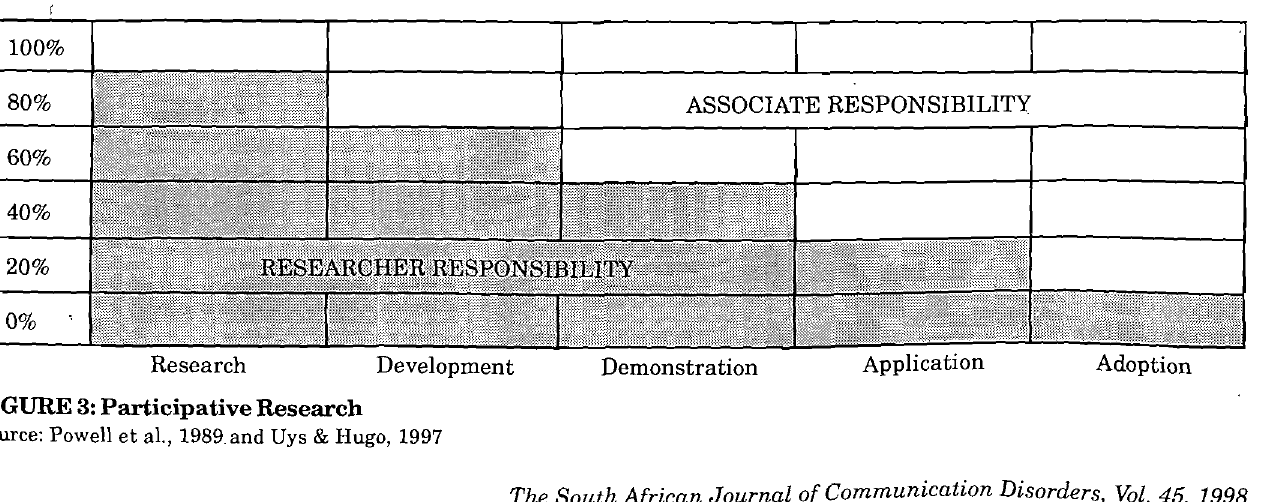
FIGURE 3: Participative Research Source: Powell et al., 1989. and Uys & Hugo,